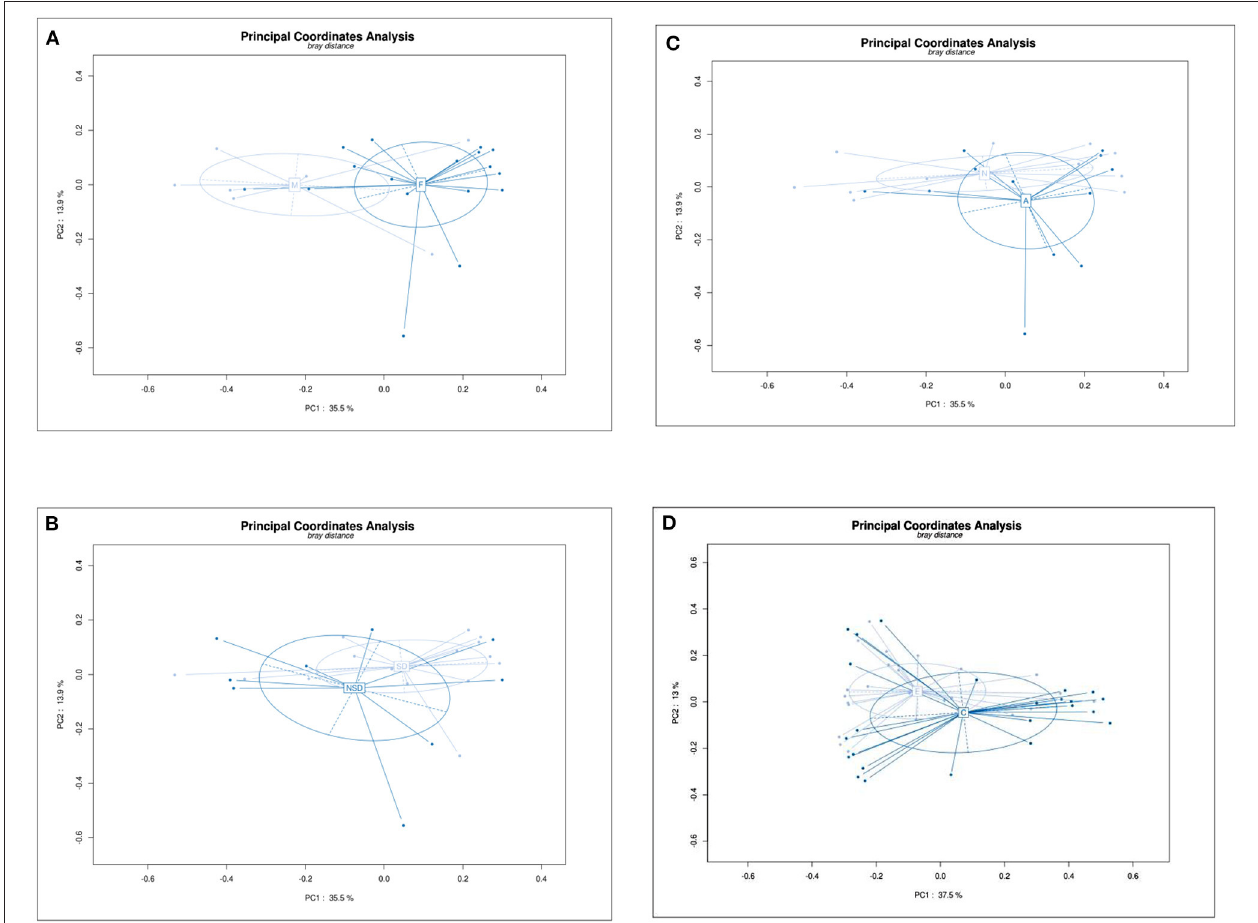
FIGURE 2 | Principal Co-ordinates Analysis (PCoA) plot showing beta diversity among samples based on the OTU abundance. Each dot represents a sample, and different color depth represents a group (marked in the middle of circle). PC1 is the principal coordinate component causing the largest difference in samples, PC2 was next, with an explanatory value shown in axis. (A) Group F and M, PC1 (35.5%) and PC2 (13.9%), p = 0.09. (B) Group NSD and SD, PC1 (35.5%) and PC2 (13.9%), p = 0.531. (C) Group N and A, PC1 (35.5%) and PC2 (13.9%), p = 0.444. (D) Group C and E, PC1 (37.5%) and PC2 (13%), p =